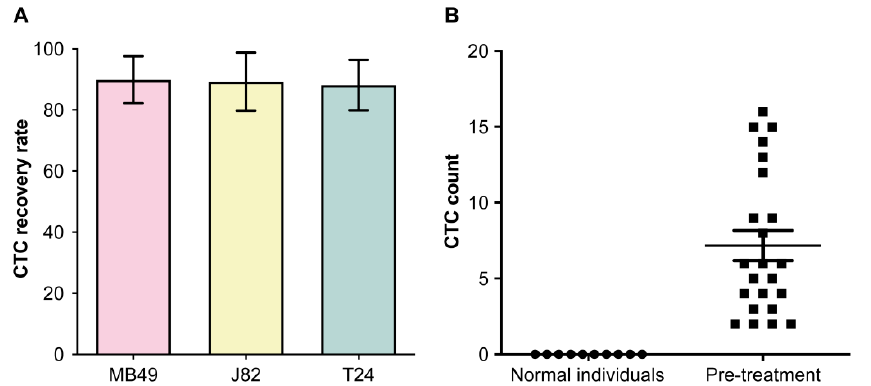
Figure 1. ( A ) Recovery rate of urothelial carcinoma (UC) cell lines using the IsoFlux system ( n = 8 for each cell line). ( B ) Circulating tumor cell (CTC) count in normal individuals and UC patients at baseline.